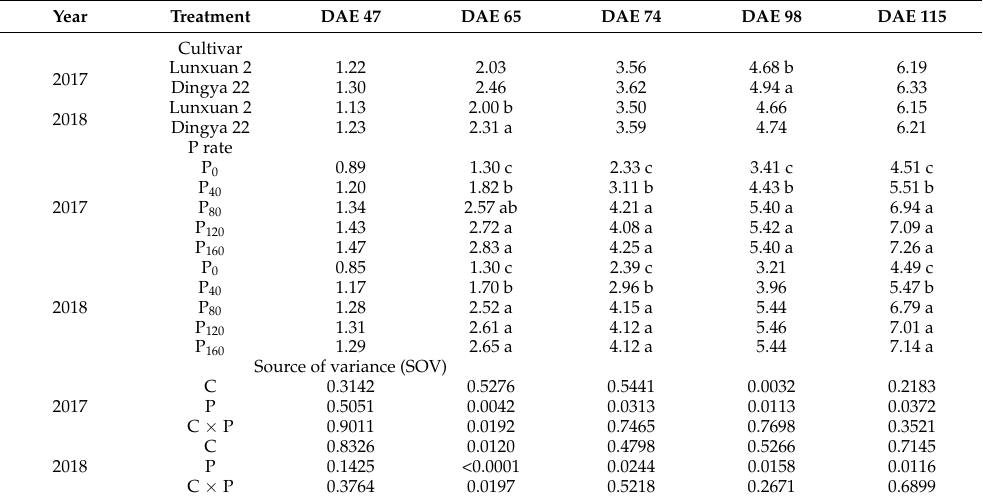
Table 1. Shoot biomass (t ha − 1 ) at Dingxi in 2017 and 2018 with two cultivars flax and five phosphorus rates.